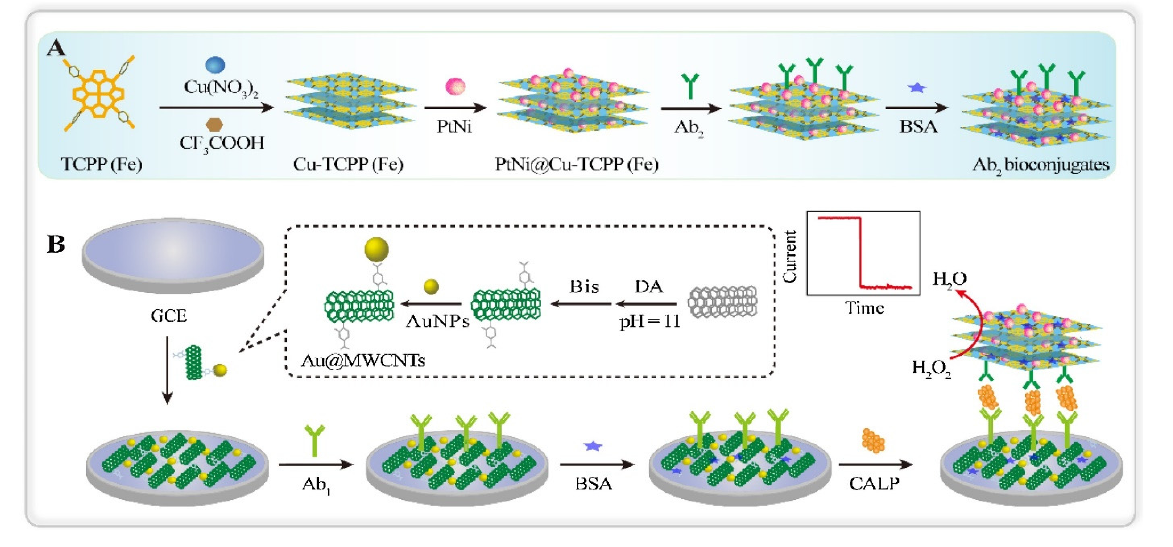
Figure 13. Scheme of ( A ) Fabrication procedure of PtNi@Cu-TCPP(Fe)-Ab 2 bioconjugates and ( B ) fabrication of electrochemical immunosensor. Reprinted from [100], Copyright (2020), with permission from Elsevier.